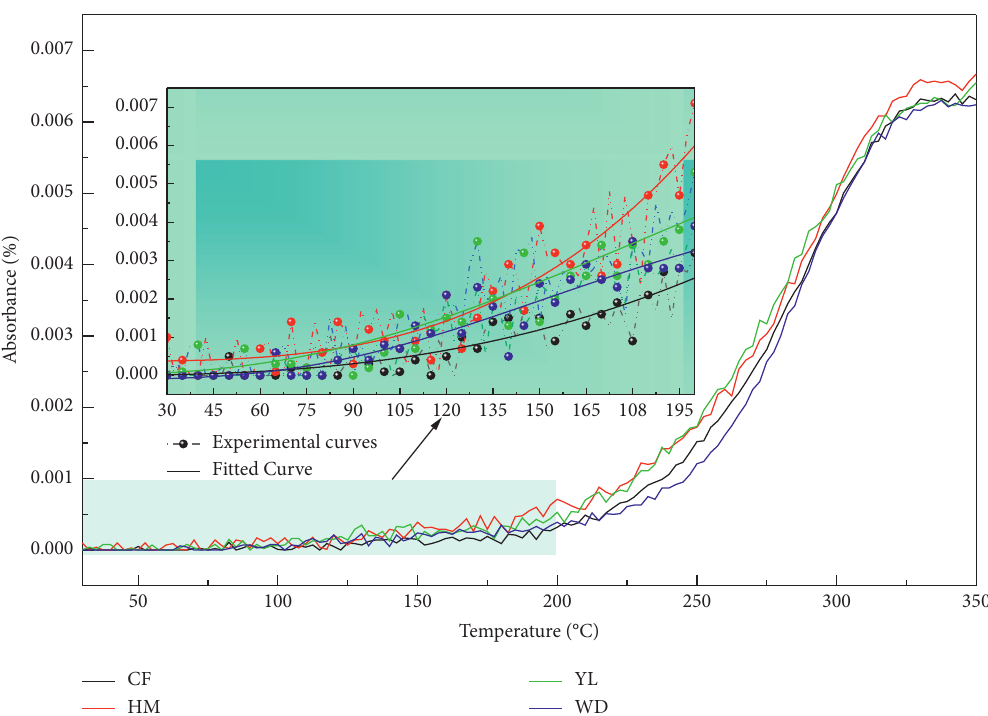
Figure 5: Infrared characteristic peak intensity of CO in the temperature-rise process of the